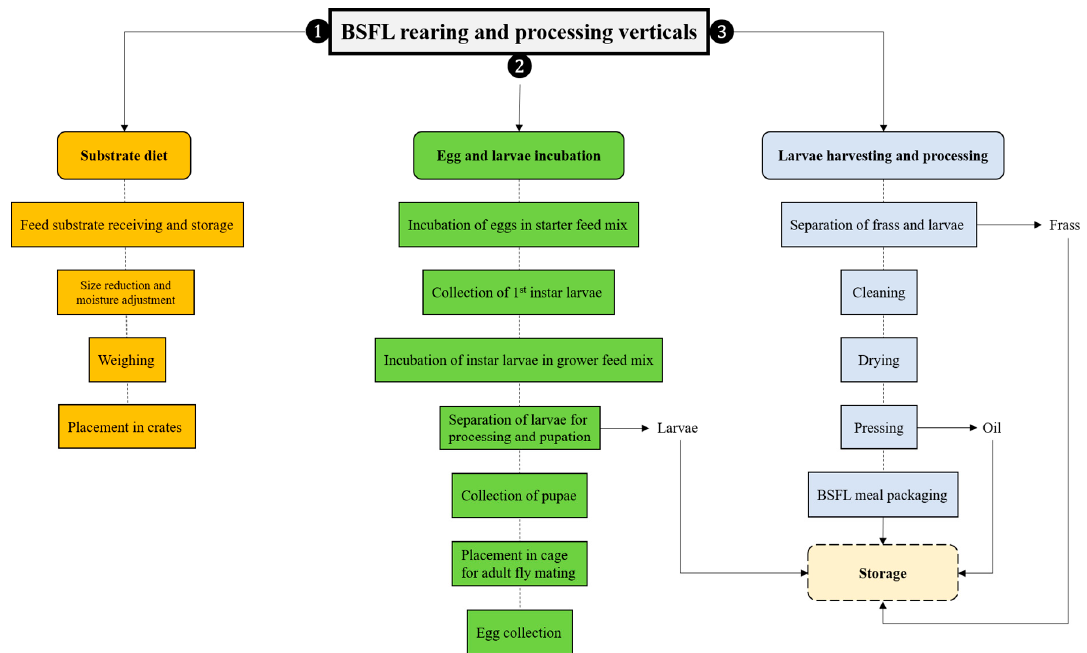
Figure 10. General overview of verticals in BSF rearing and processing.